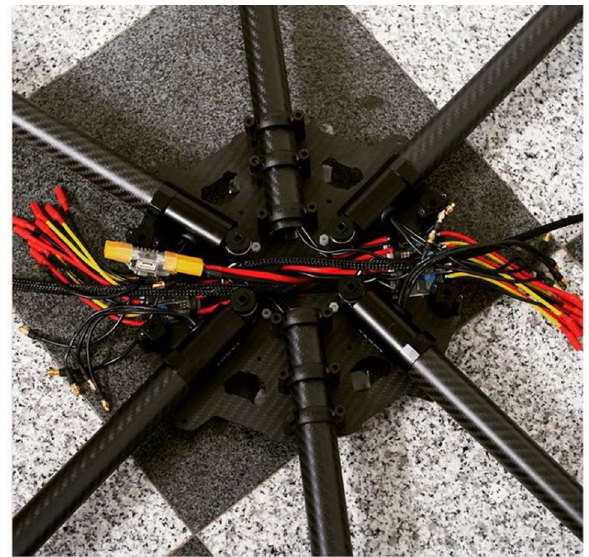
Figure 5. The initial wiring layout of the drone without the bottom plate of the frame.